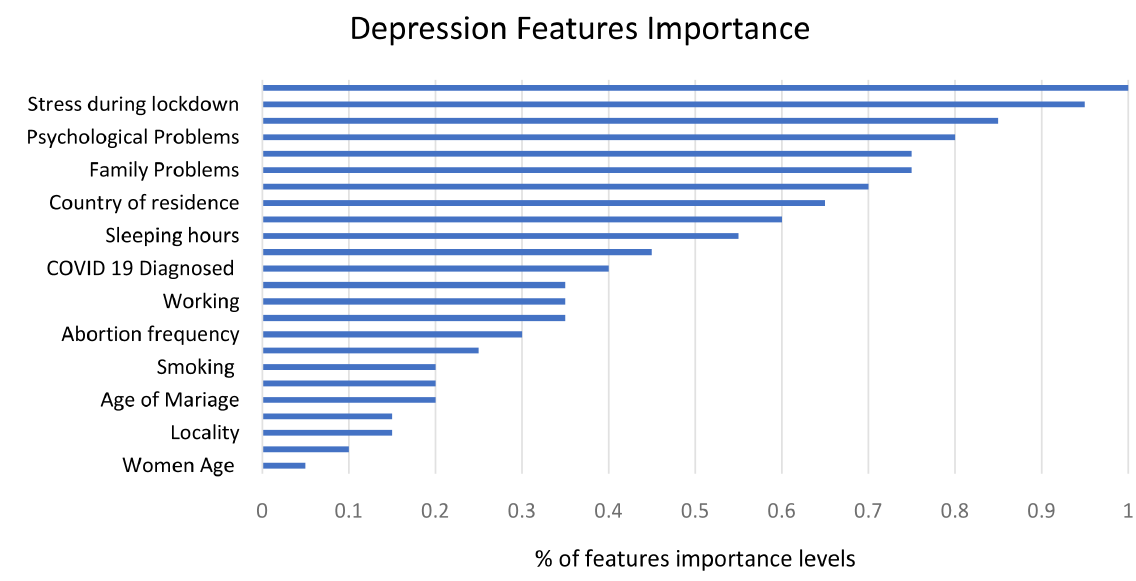
Figure 6. Variables’ importance ranking analysis in predicting depression